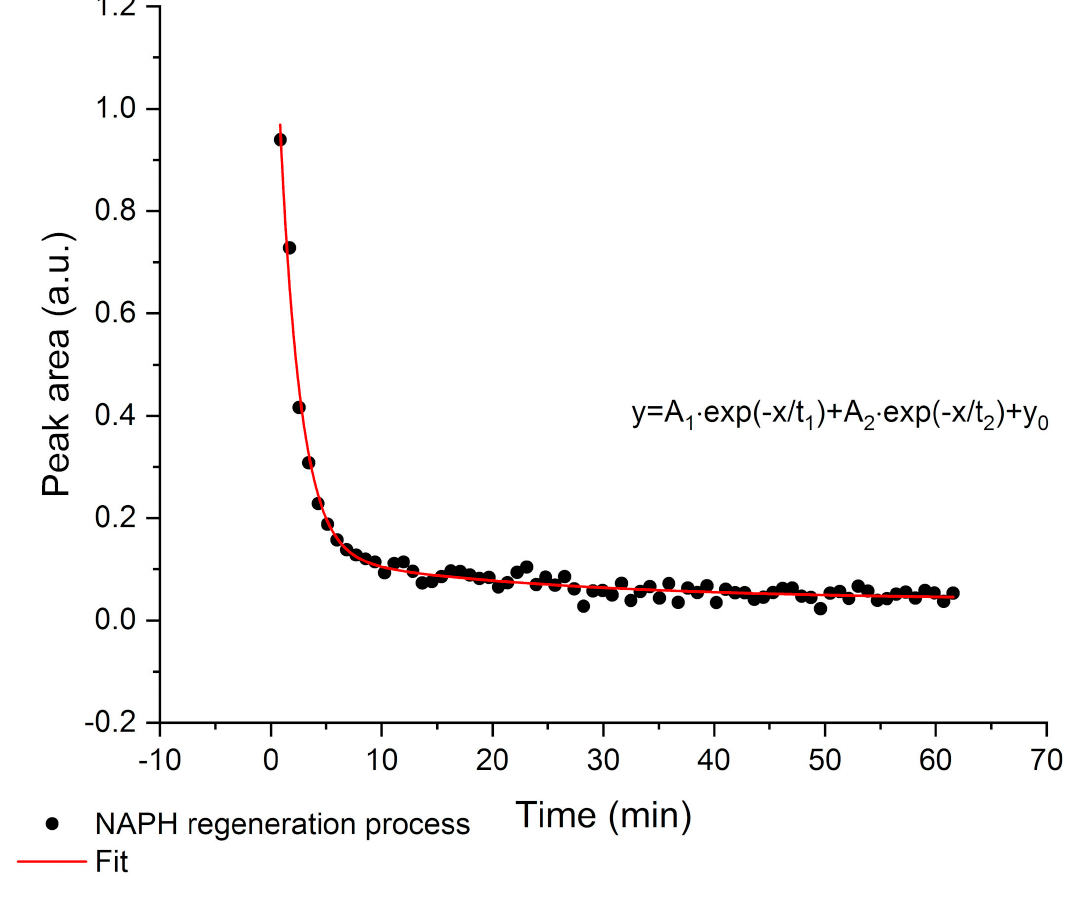
Figure 6. Regeneration of the E / P-co polymer layer after enrichment of 25 ppm NAPH. A MeOH / water mixture (1:10, v / v ) was used for recovering the polymer membrane. Subsequently, deionized water was flushed through to remove residual MeOH before starting the next measurement. For the entire regeneration process, the maximum flow rate of 12 mL / min was applied. An exponential fit was applied to the experimental data points. Table 6. Exponential fit function for the regeneration process with MeOH / water and subsequently water after enriching 25 ppm NAPH a